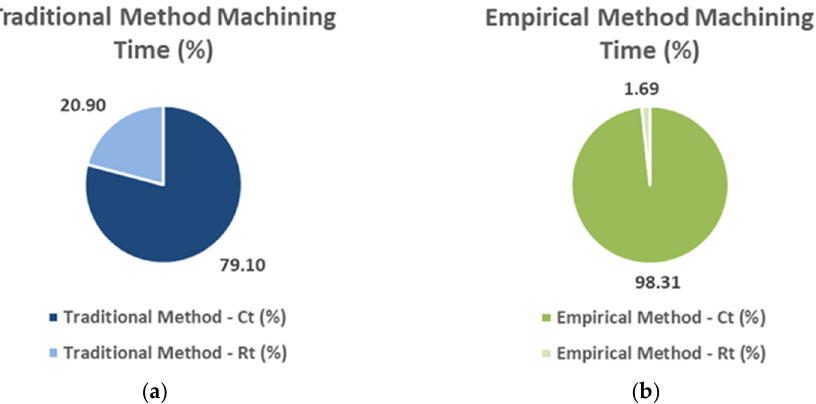
Figure 4. Traditional method ( a ) and empirical method ( b ) machining time in percentage (Ct—cutting time; Rt—rapid travelling time).